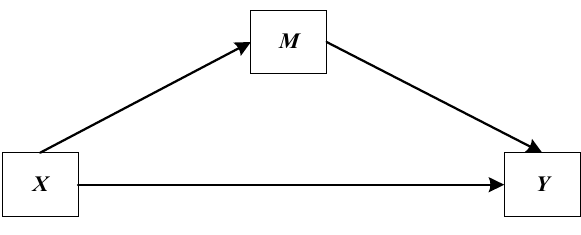
Figure 2. A simple mediation model (Model 4) in the path diagram form.